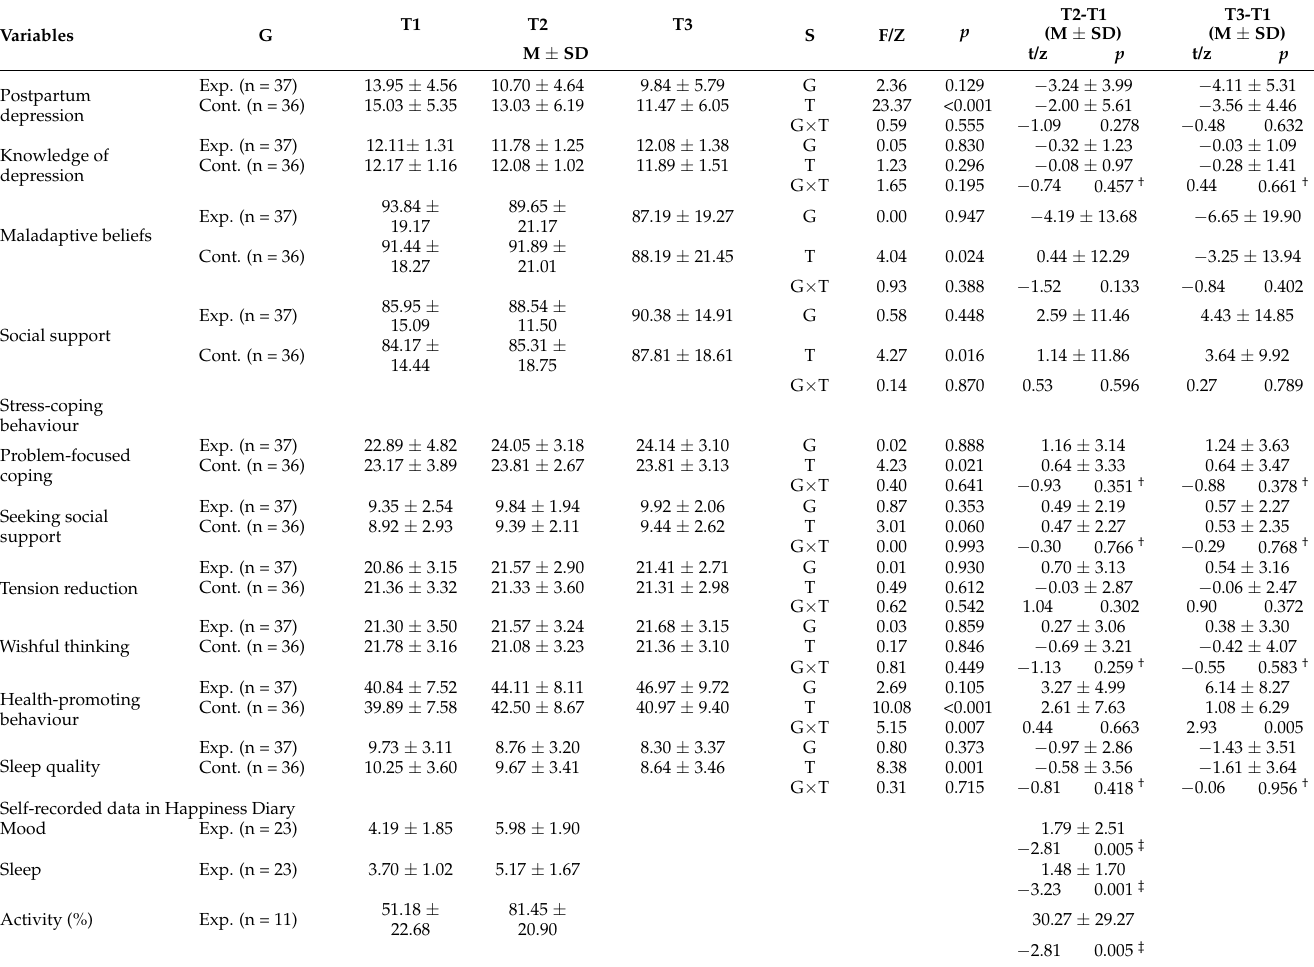
Table 3. App Effects on Dependent Variables (N =